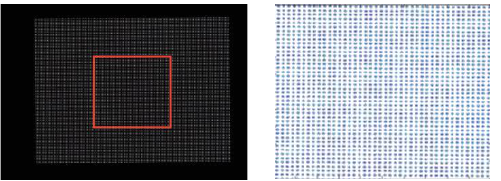
Figure 7. Pictures of center camera (Red box in the figure is the window).